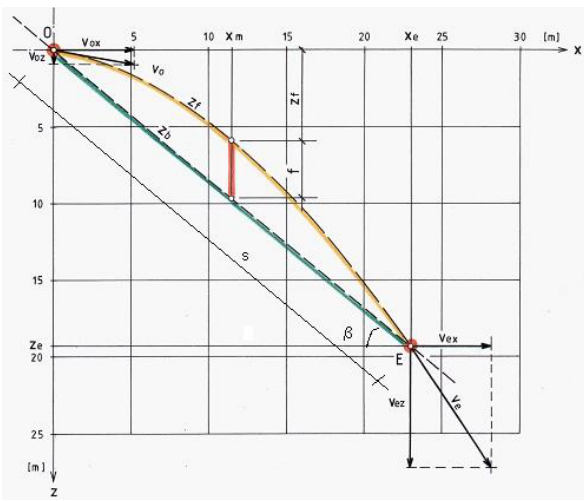
Fig. 8. Details of air parabola with velocity vectors.